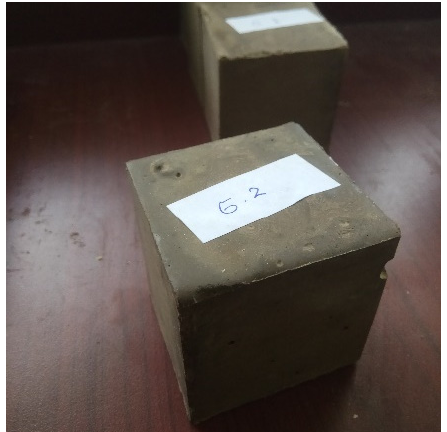
Figure 2. Mortar geopolymer made of coal fly ash and dry activator from silica geothermal sludge.